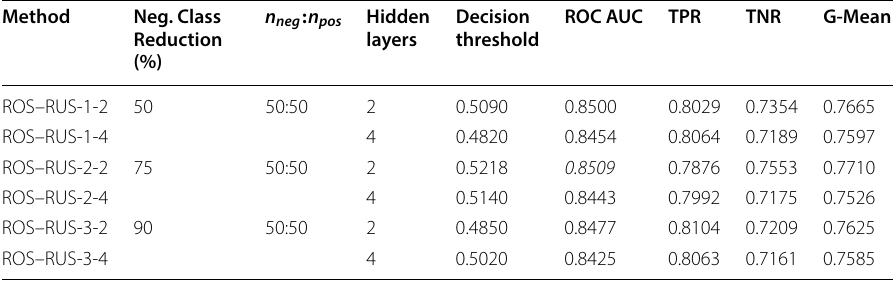
Italic font indicates the maximum ROC AUC score